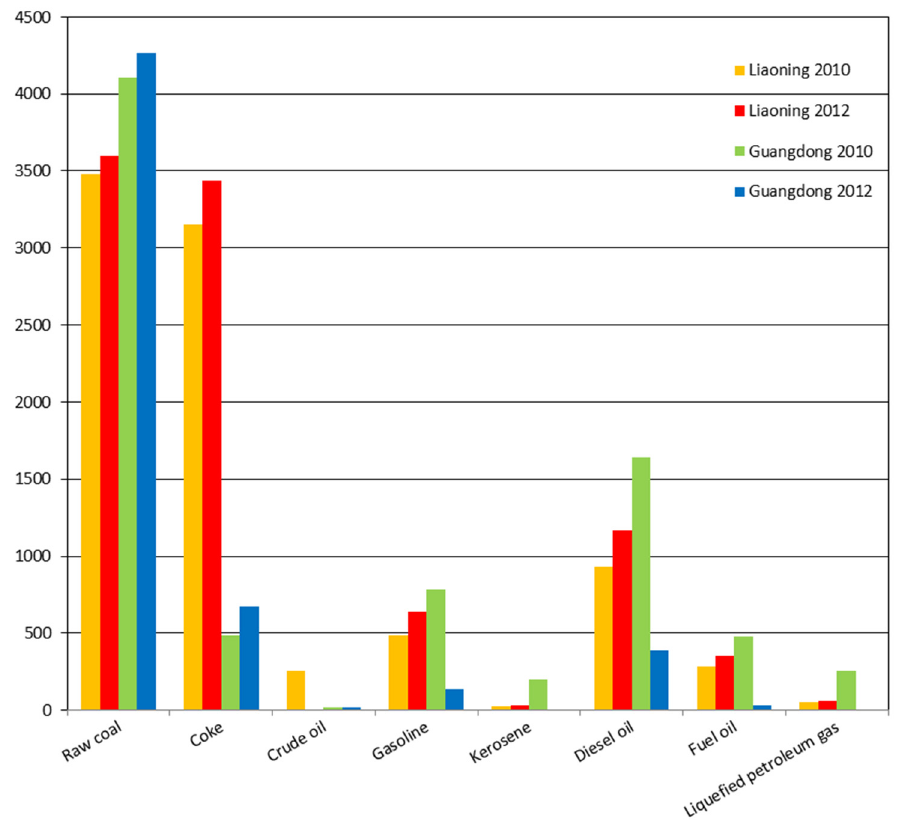
Figure 6. Energy consumption in Liaoning and